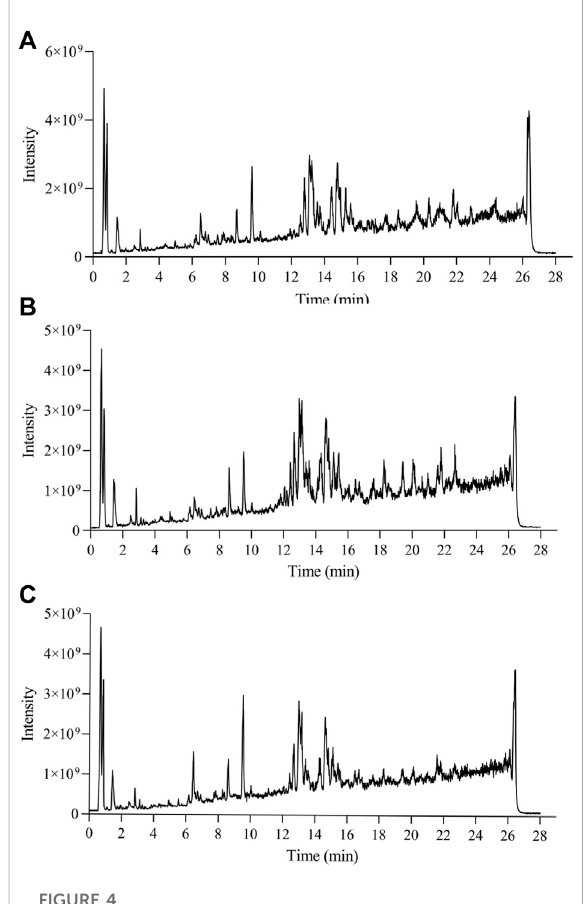
FIGURE 4 Total ion chromatograms of WKY (A) , SHR (B) Hawthorn treated (C) in positive ion mode obtained from UPLC-QE-MS